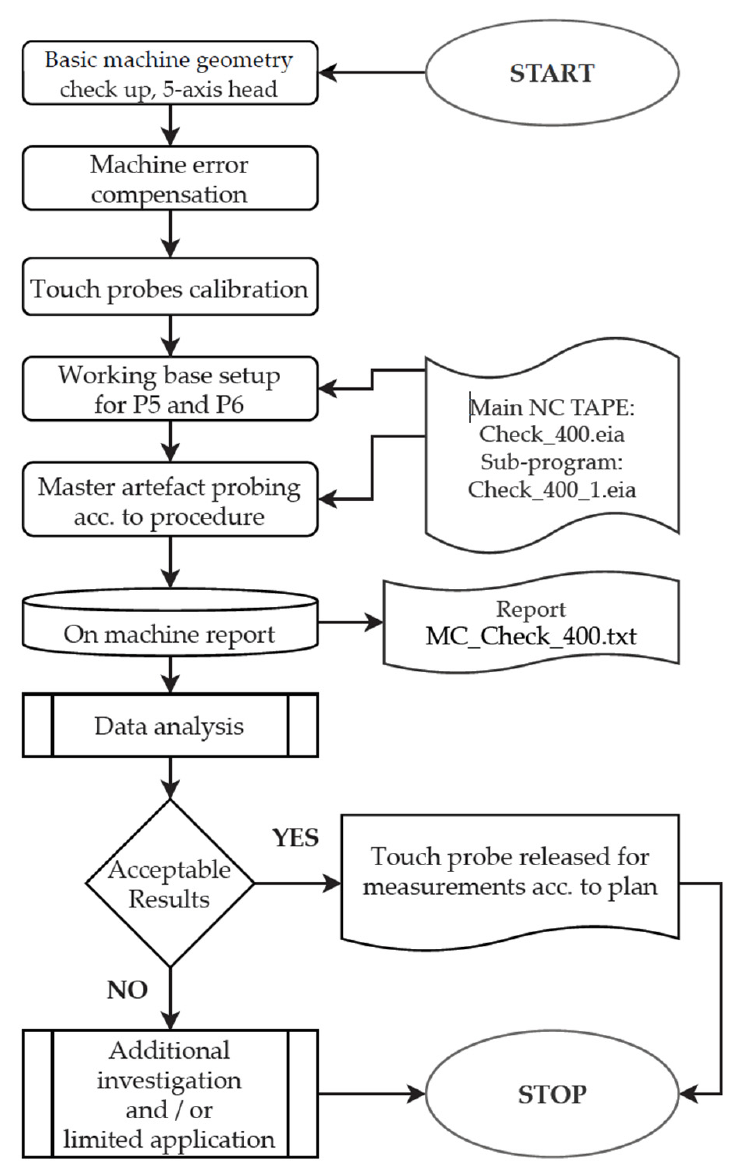
Figure 8. Flow chart of probing system performance proof.